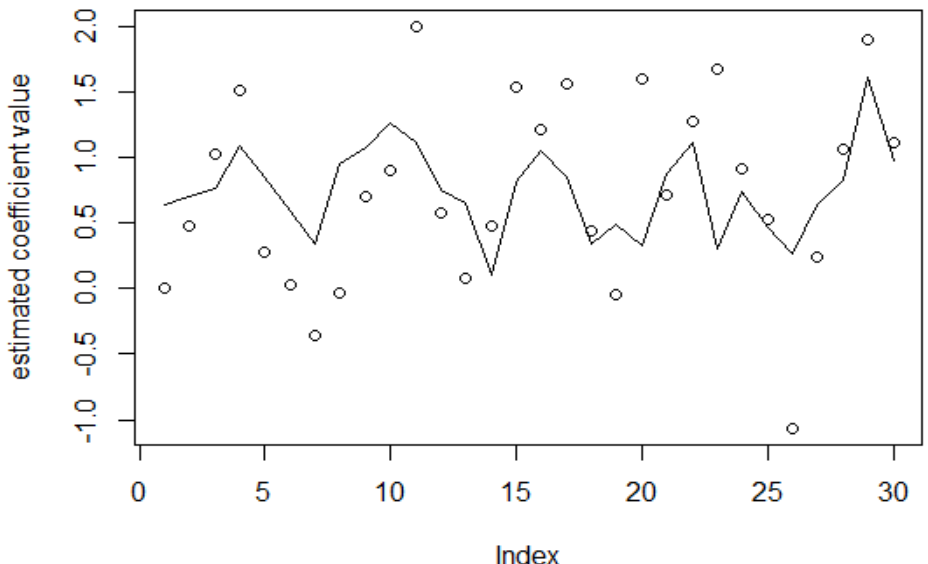
Figure 3. Coefficient value dynamics for β t 0